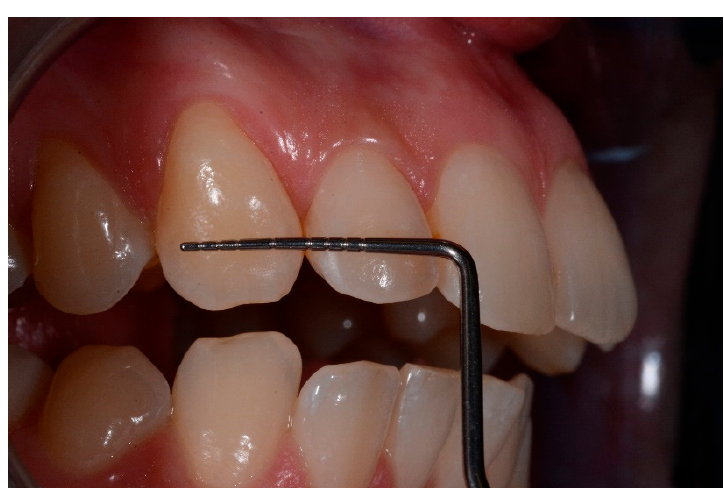
Medicina 2020 , 56 , x FOR PEER REVIEW